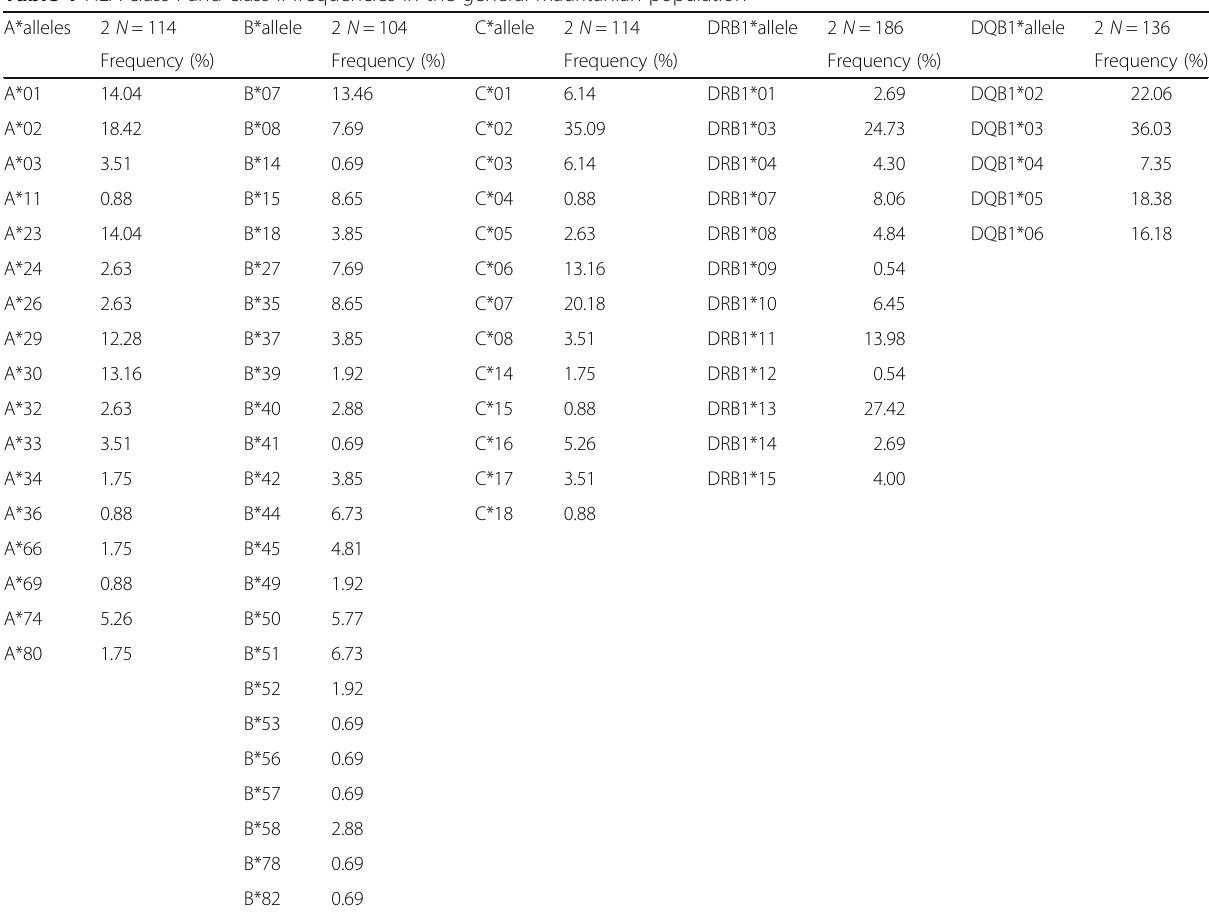
Table 1 HLA class I and class II frequencies in the general Mauritanian